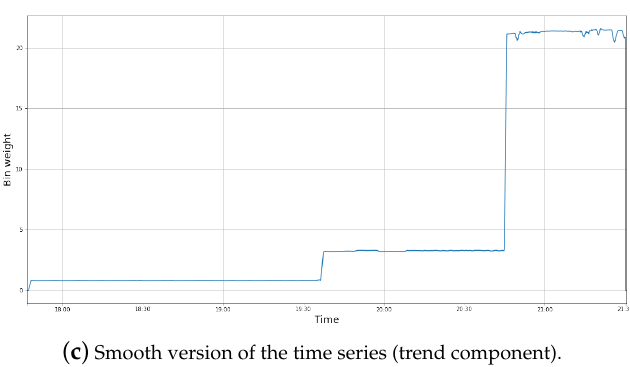
Figure 6. Data cleaning example.